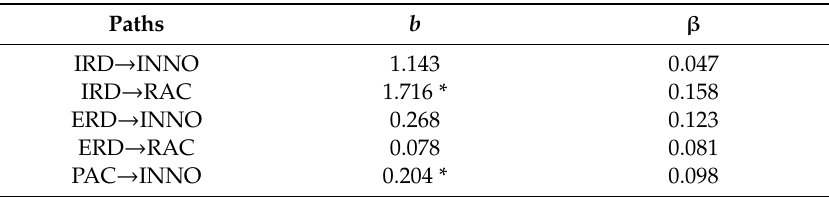
Table 8. Indirect e ff ects in the